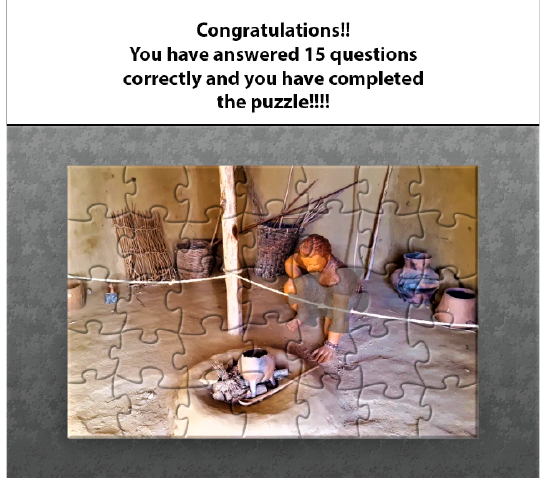
Figure 9. A puzzle being completed by pieces being placed correctly.